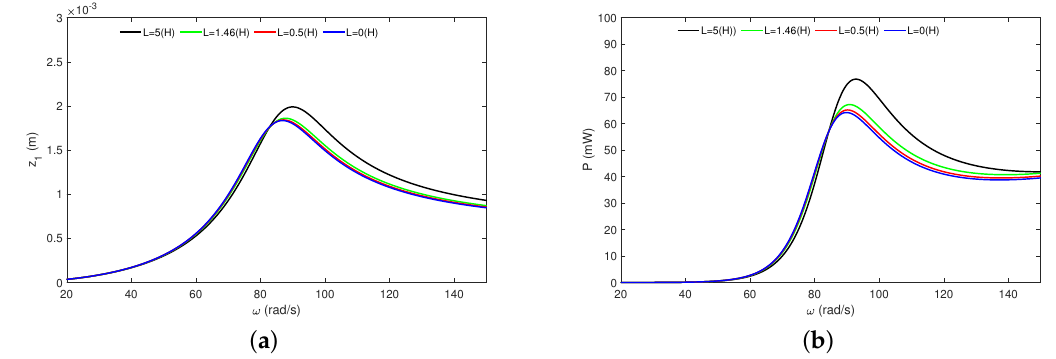
Figure 9. Analytical HBM results. Magnet’s resonance curves ( a ) and the recovered power ( b ) under the coil inductance influence. The results have been calculated for amplitude Q = 0.6 mm and the resistance R = 2 k Ω . The results have been obtained from Equations (27) and (28). All resonance curves are stable.